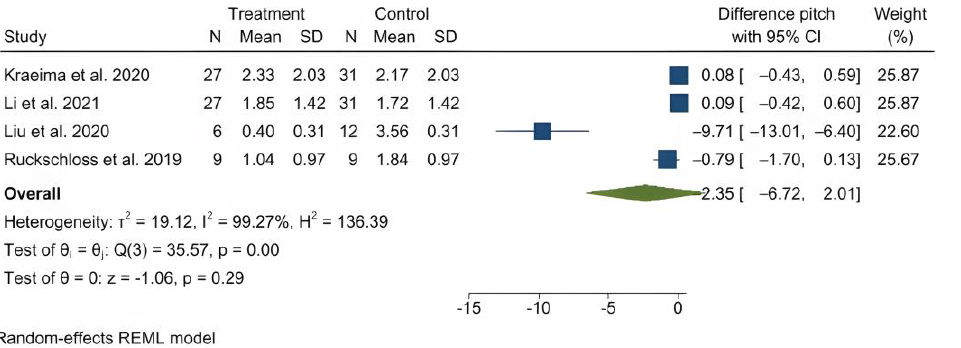
Figure 12. Forest plot showing differences in pitch deviation between PSI and control (conventional osteosynthesis and CAD/CAM splint or wafer).